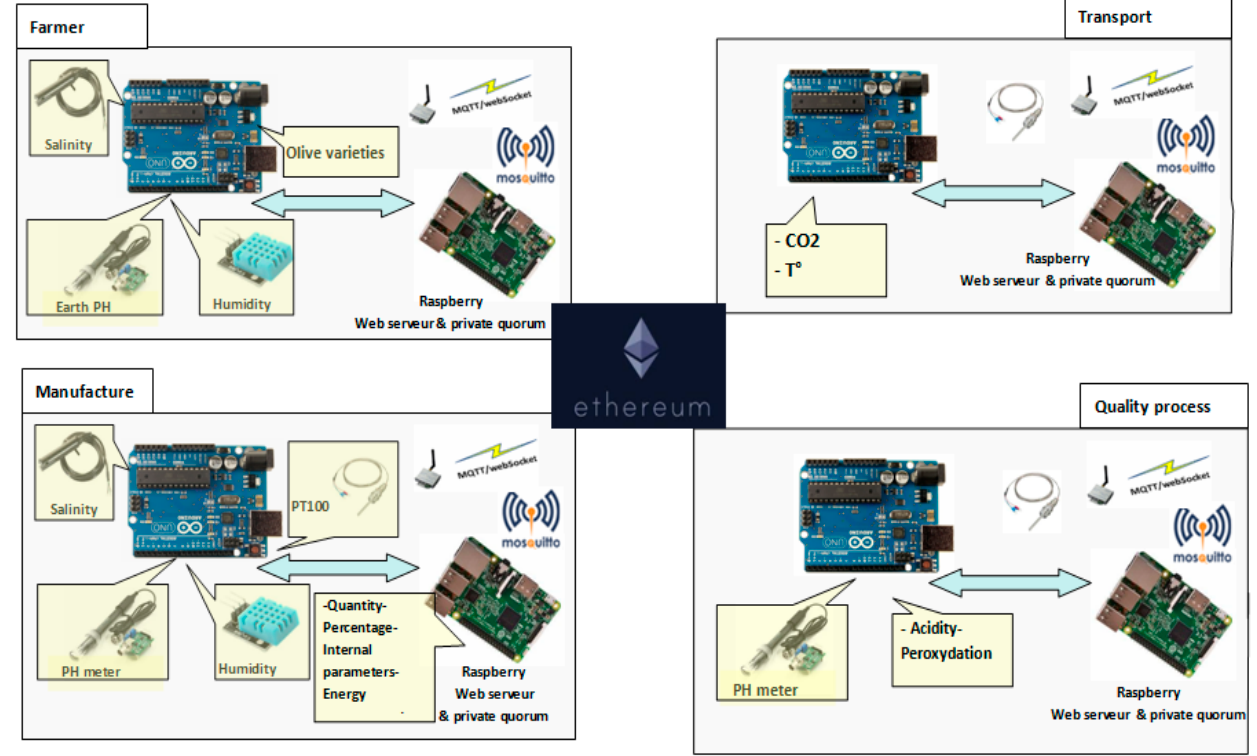
Figure 5. Global system